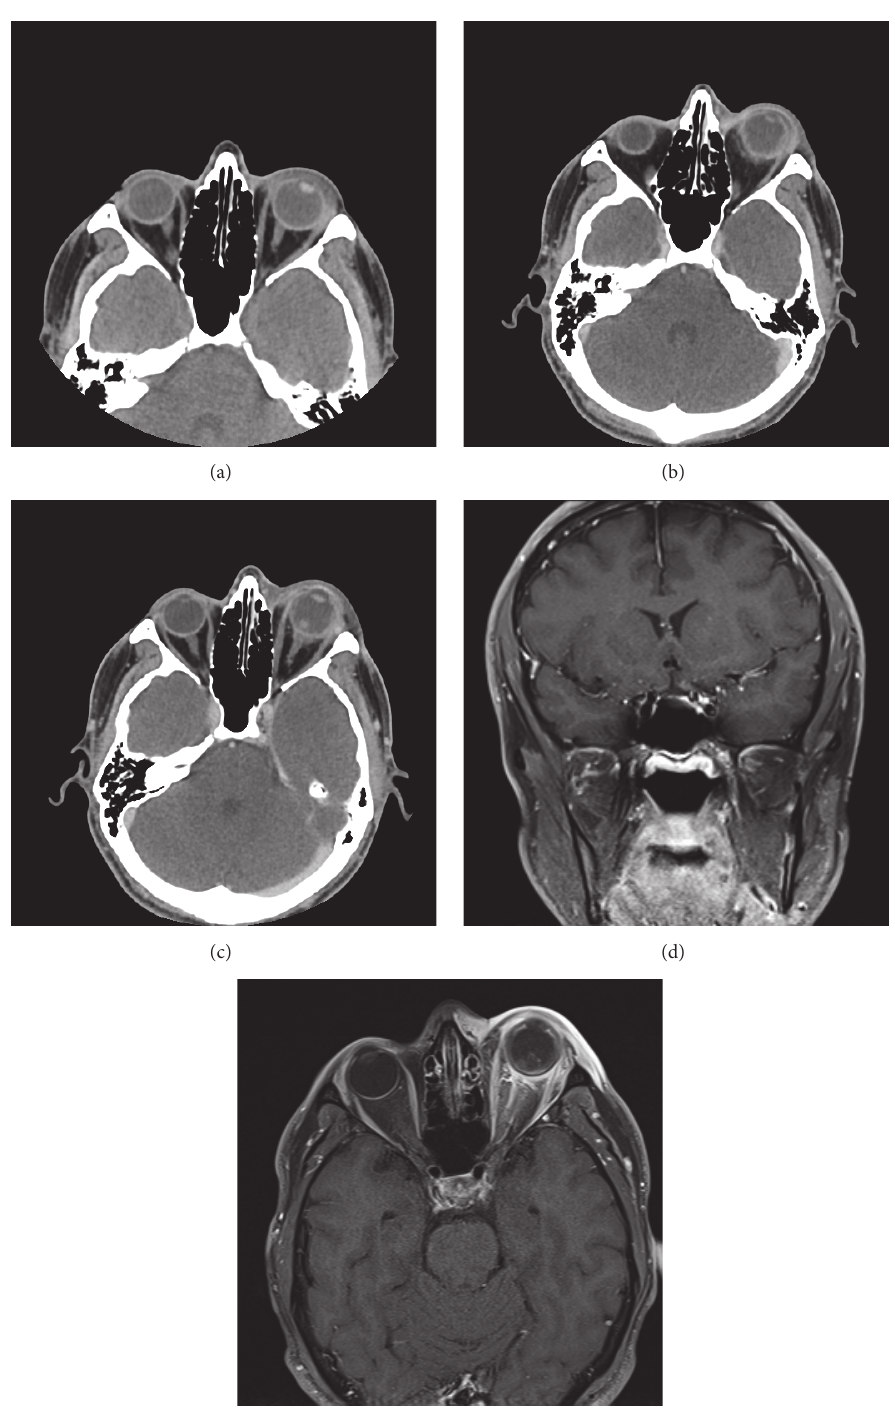
Figure 1: (a) Initial noncontrast CT with left periorbital soft tissue swelling. (b) Follow-up CT-scan with progressive postseptal extension of inflammation with shaggy appearance to the posterior sclera. (c) New vitreous opacity in the posterior globe. (d) MRI with thickening of the globe and scleral enhancement along the inner wall. The native intraocular lens has been displaced into the vitreous. (e) MRI with enhancement along the left optic nerve sheath to the prechiasmatic optic